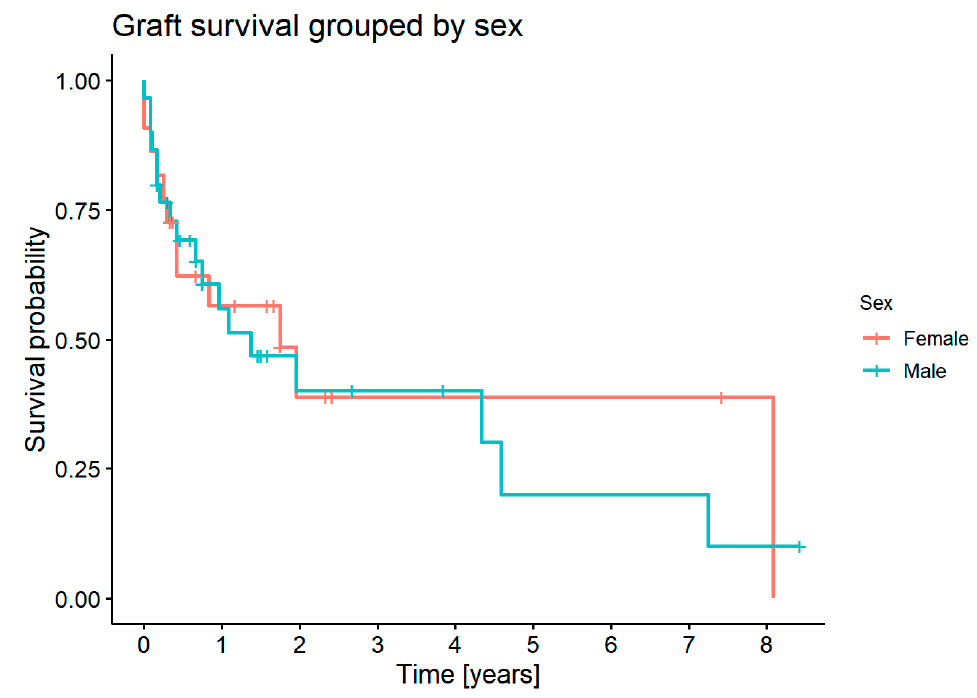
Figure 7. Survival probability for each etiology.